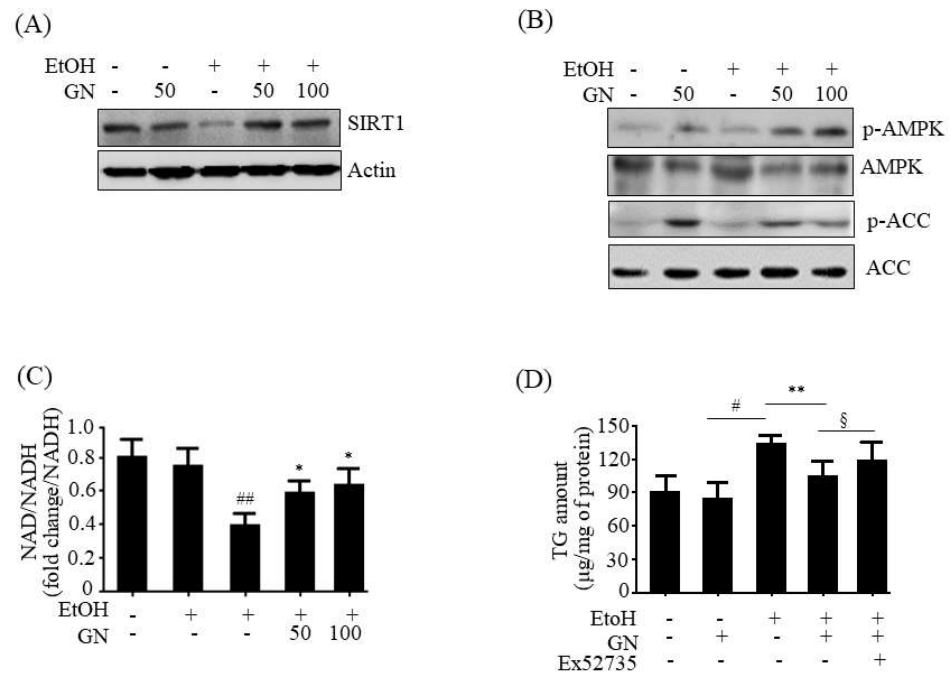
Figure 9. Gomisin N reverses ethanol-mediated reduction in SIRT1 and phosphorylated AMPK in HepG2 cells. HepG2 cells were treated with 50 mM ethanol in the presence or absence of GN (50 or 100 µ M) for 24 h. ( A ) Western blot analysis of SIRT1. ( B ) Western blot analysis of p-AMPK and p-ACC. ( C ) Measurement of NAD + /NADH ratio. ( D ) HepG2 cells were pretreated with GN (100 µ M) for 3 h or with Ex52735 (10 µ M) for 6 h and then treated with ethanol (100 µ M). Measurement of intracellular TG levels. Values are the mean ± SD of triplicate experiments. # p < 0.05, ## p < 0.01 vs. untreated control, * p < 0.05, ** p < 0.01 vs. ethanol-treated group. § p < 0.05 vs. ethanol and GN-treated group.